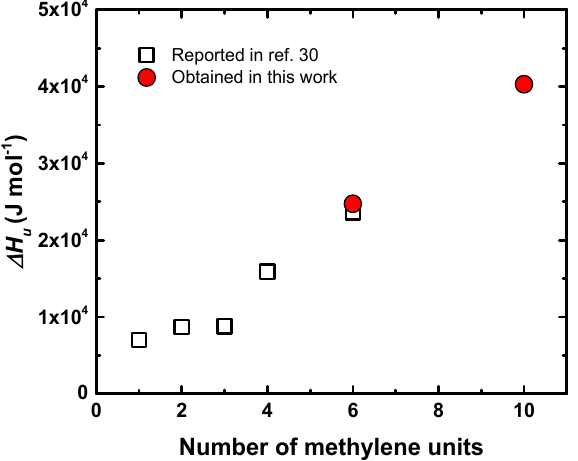
Figure 9. ∆ H u values of polyethers as a function of the number of methylene units in the repeating unit. The black points are values reported in the literature [29] and the red points are the values obtained in this